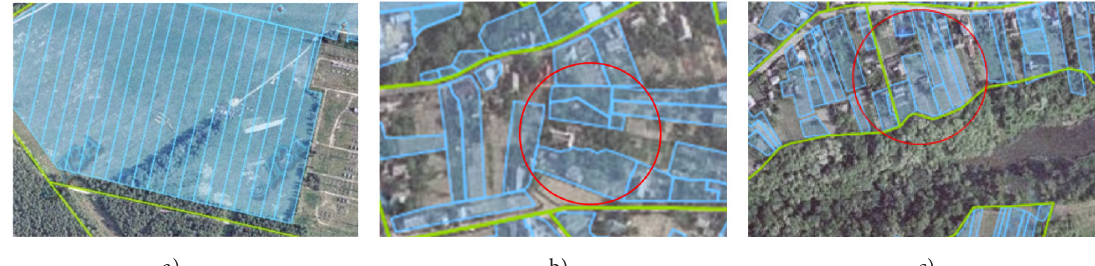
Figure 2. Land massive placement lacks